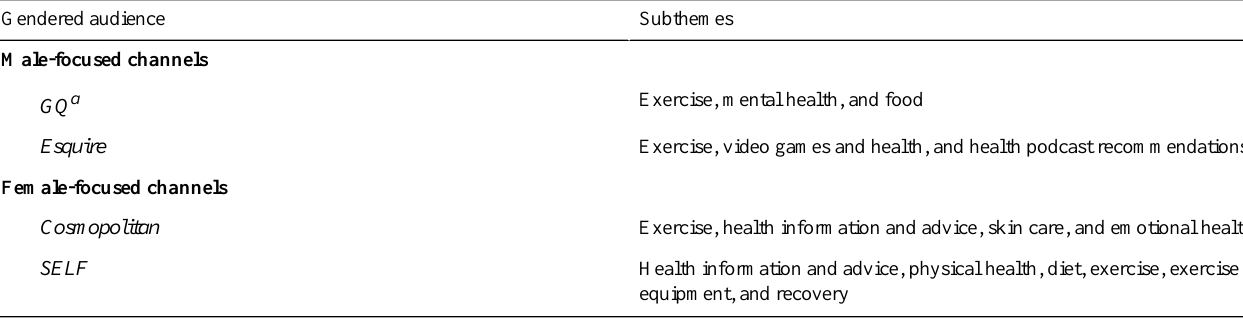
Table 2. Health content subthemes of male- and female-focused general health